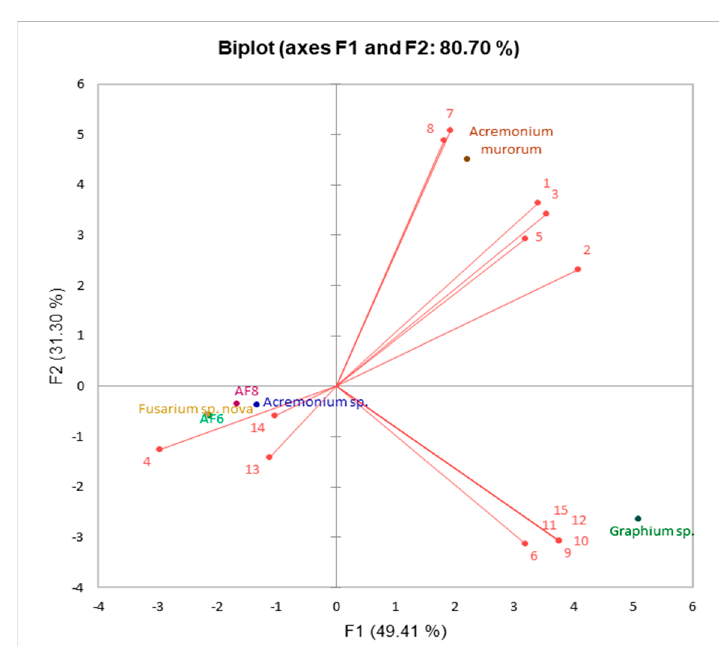
Figure 3. Principal component analysis (PCA) plot of the scores (volatile compounds emitted by symbionts) loading by dotes and loadings (symbionts) indicated by lines based on the first and sec- ond principal components. Numbers represent the compounds 1 to 15 in Table 1.